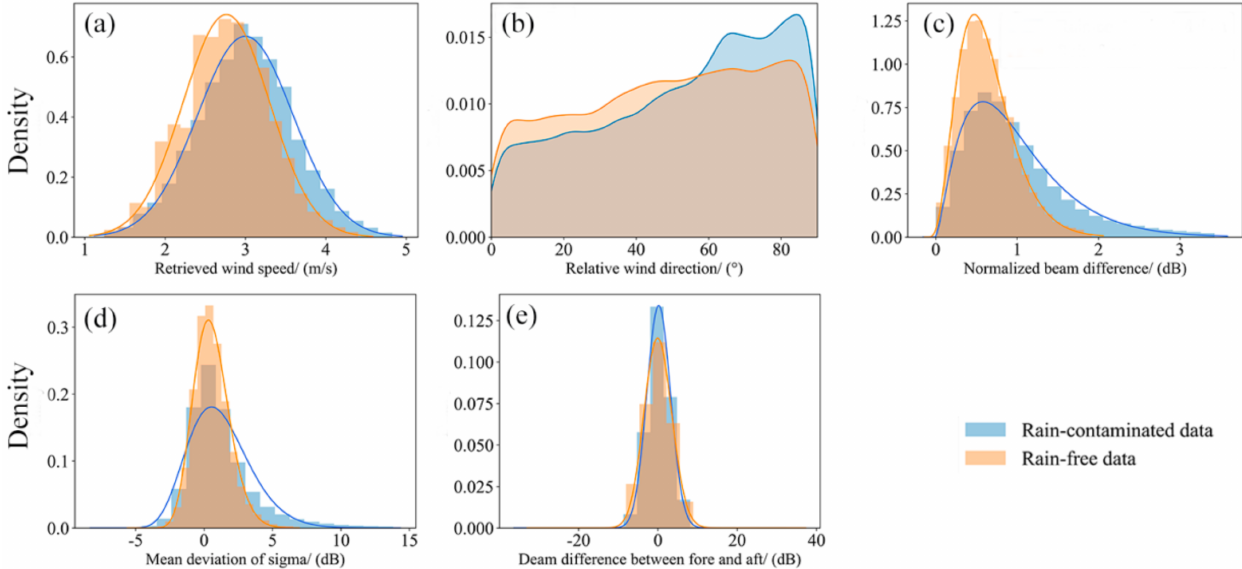
Figure 4. Comparison of the influence of rain on sensitive parameters. The rain-sensitive parameters are as follows: ( a ) retrieved wind speed; ( b ) relative wind direction; ( c ) normalized beam difference; ( d ) mean deviation of NRCS; ( e ) beam difference between fore and